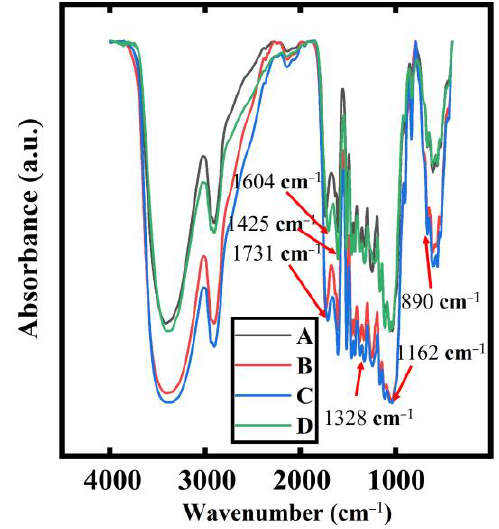
Figure 3. FTIR spectra of the moso bamboo.